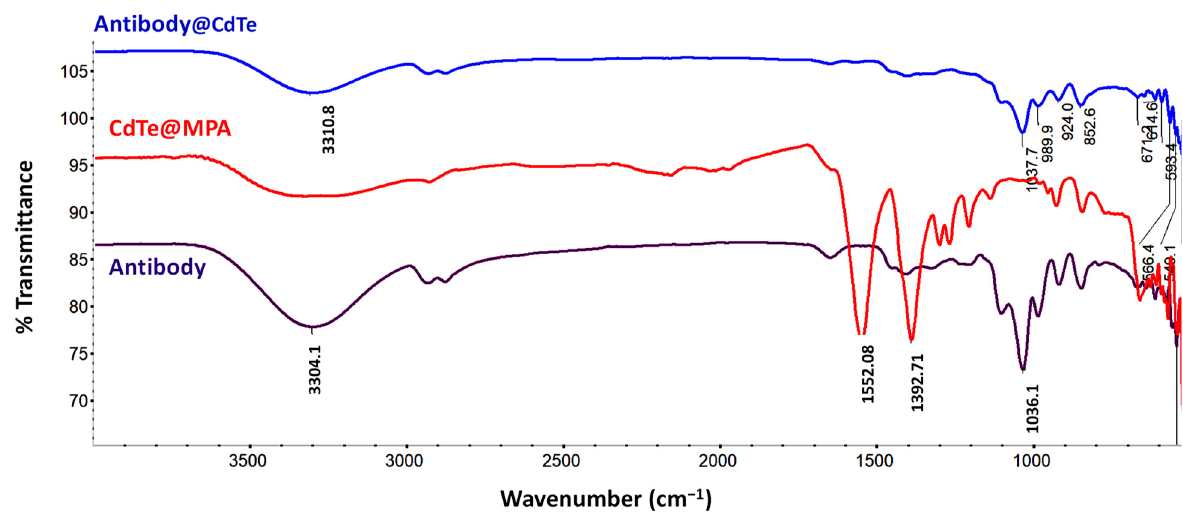
Figure 4. FTIR spectra of the CdTe@MPA QDs (red) (i), of the CA 15-3 antibody (blue) (ii), and of the CdTe@MPA conjugates (purple) (iii).